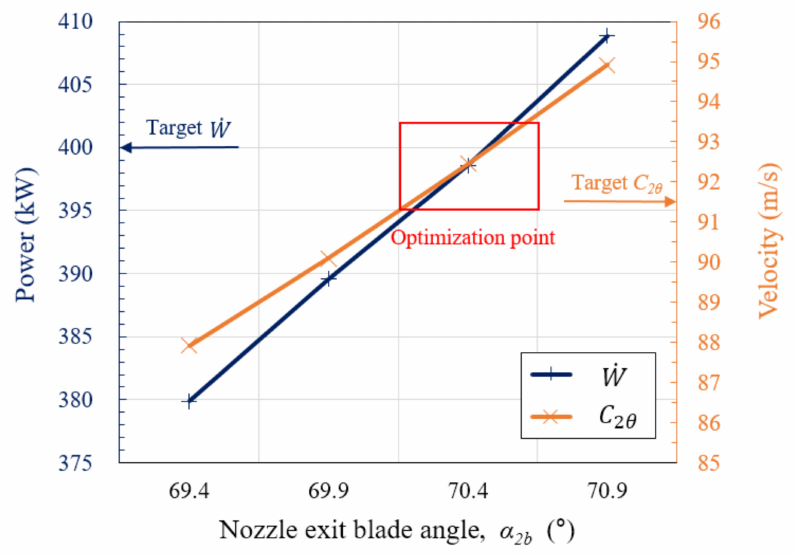
Figure 8. CFD results according to the blade angle of the nozzle exit ( α 2 b